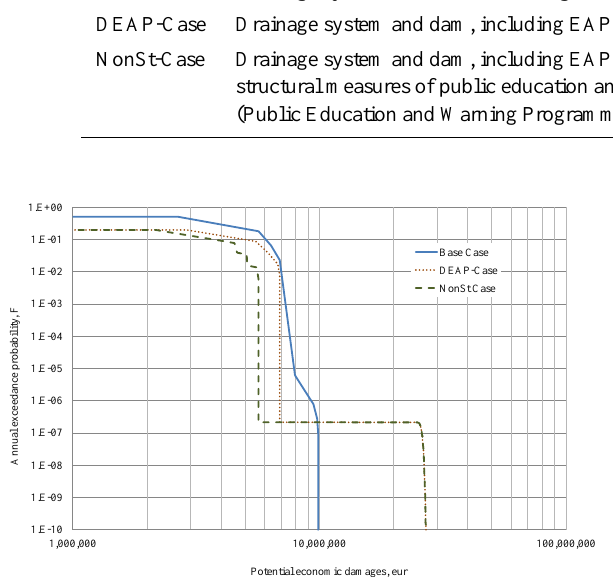
Fig. 16. FD-curves for all analysed situations.